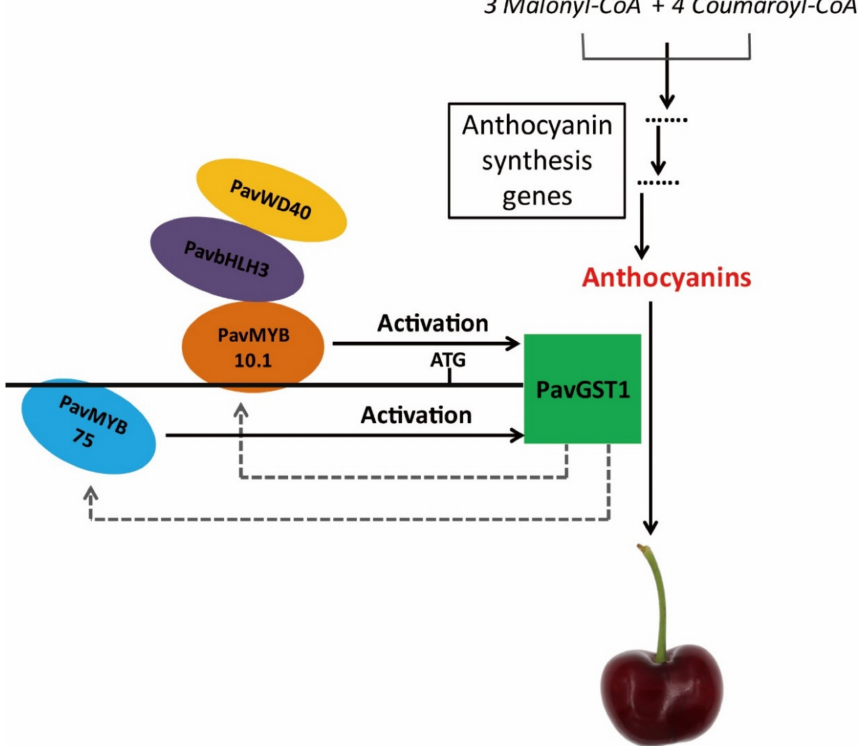
Figure 8. Proposed model of the role of PavMYB10.1 and PavMYB75 transcription factors in the positive regulation of anthocyanin accumulation by PavGST1 in sweet cherry. In this model, PavMYB10.1 and PavMYB75 bind to different MBS recognition sites of the PavGST1 promoter to activate PavGST1